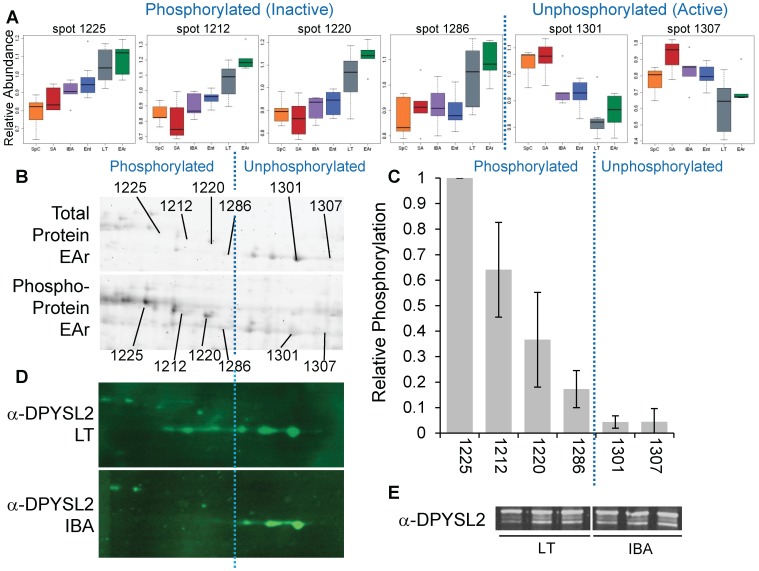
Posttranslational modification of a microtubule regulating protein. (A) Boxplots of the relative abundance of six DPYSL2 isoforms reveal two reciprocal abundance patterns; animal groups are as in Figure 1. (B) Representative images from an EAr 2D gel stained for total protein (top panel) or phosphoprotein (bottom panel); note the transition between the two patterns in panel A occurs at an isoelectric point consistent with a shift between the phosphorylated and unphosphorylated form of the protein. (C) Relative degree of isoform phosphorylation quantified from EAr and IBA phosphoprotein-stained gels increases as spots migrate further left on 2D gels (i.e., become more acidic), and supports categorizing the two abundance patterns by phosphorylation state. (D) Representative 2D western blots from LT and IBA show that the unphosphorylated forms are most abundant in euthermic states such as IBA, while phosphorylated forms are largely absent. (E) A 1D western blot (α-DPYSL2) shows no significant change in total DPYSL2 content among forebrain of LT, IBA or SA 13-lined ground squirrels (SA data not shown). In panels A–D the dotted blue line separates the phosphorylated and unphosphorylated forms of DPYSL2; in panels D–E, DPYSL2 antibody labeling is denoted as α-DPYSL2.